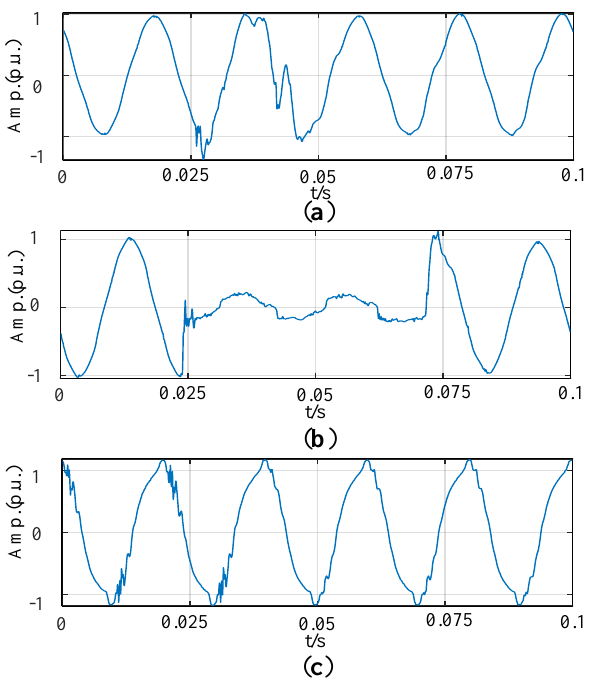
Figure 7. Power quality measured signal ( a ) transient oscillation; ( b ) sag; ( c ) harmonics.